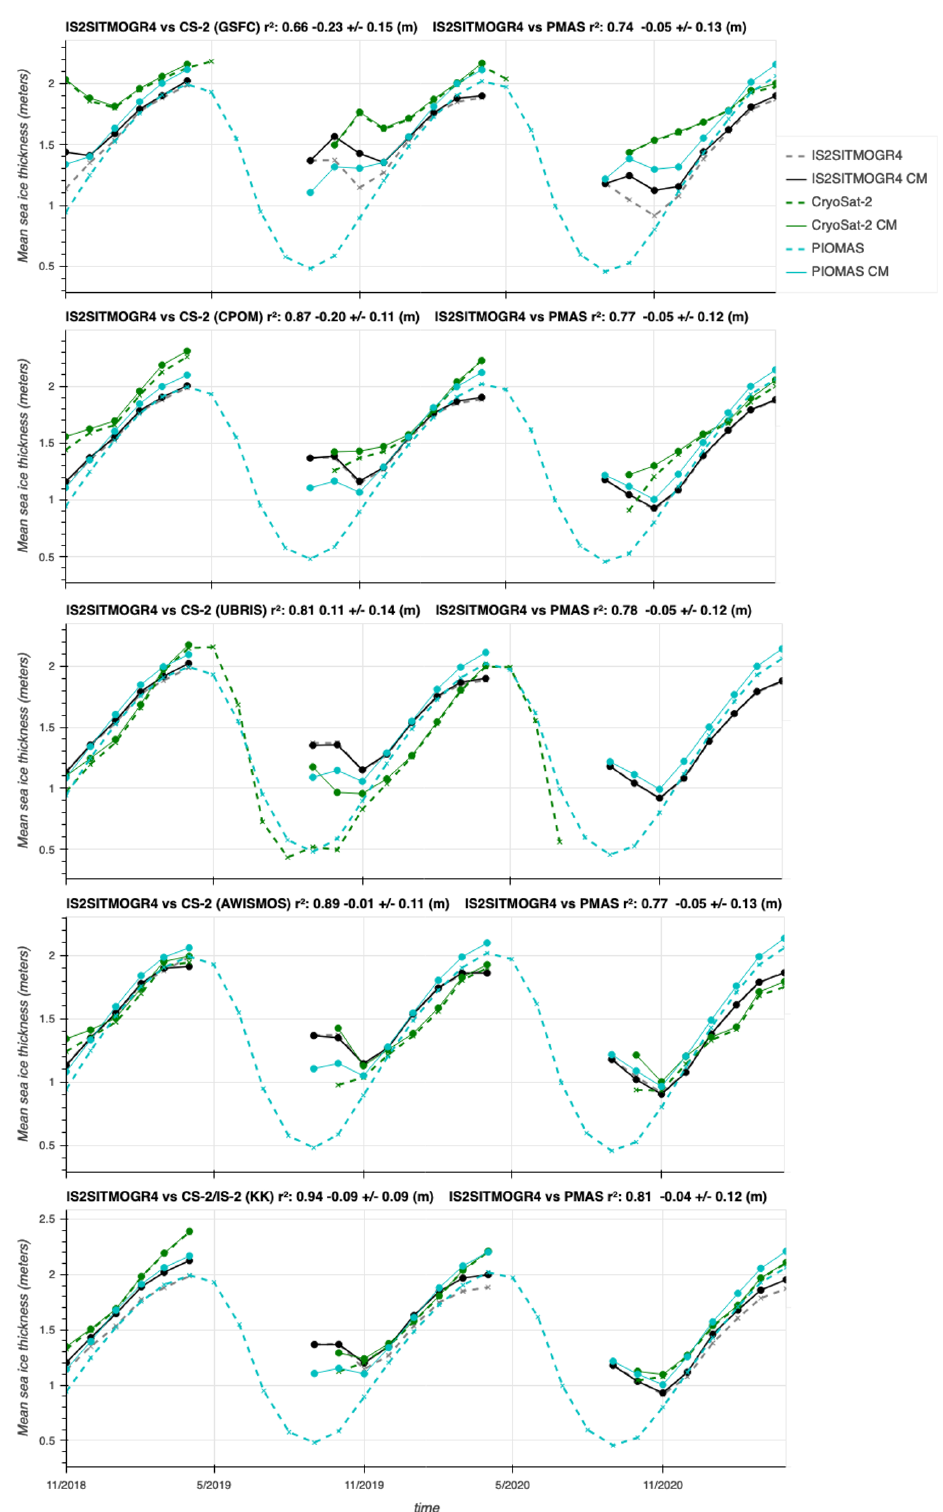
Figure 11. Comparisons of IS2SITMOGR4, v002 (ICESat-2), against thickness estimates from PIOMAS and various CryoSat-2 thickness products. CM: mean calculated using a common spatial grid cell mask in the given month. Correlation coefficient, mean bias and standard deviation of differences between IS2SITMOGR4CM and CryoSat-2 CM and IS2SITMOGR4 and PIOMAS are given in each sub-heading.